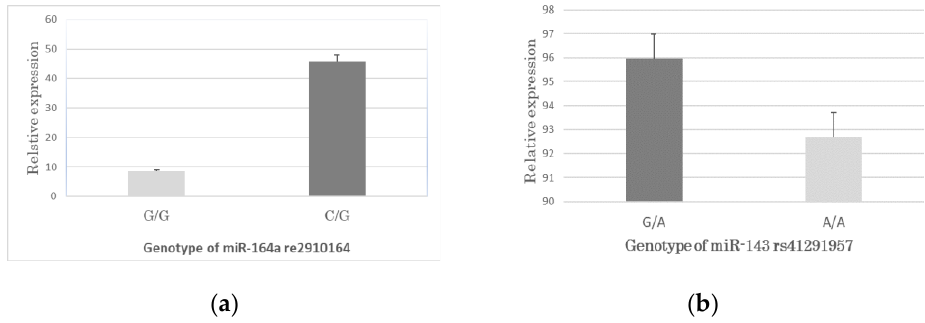
Figure 3. miRNA expression in the CAD group with two SNPs. ( a ) shows miR-146a with rs2910164 G/G and C/G genotype; ( b ) shows miR-143 with rs41291957 A/A and G/A